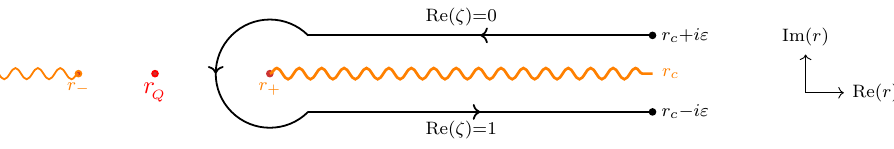
Figure 2 . The complex r plane with the locations of the two regulated boundaries (with cut-off marked. The grSK contour is a r c ), the outer and inner horizons at r ± and the Ohmic radius r Q codimension-1 surface in this plane (drawn at fixed v ). As indicated the direction of the contour is counter-clockwise and it encircles the branch point at the outer horizon with the cut running out to the boundary. The cut emanating from the inner horizon, and the locus at the Ohmic radius are not encountered by the